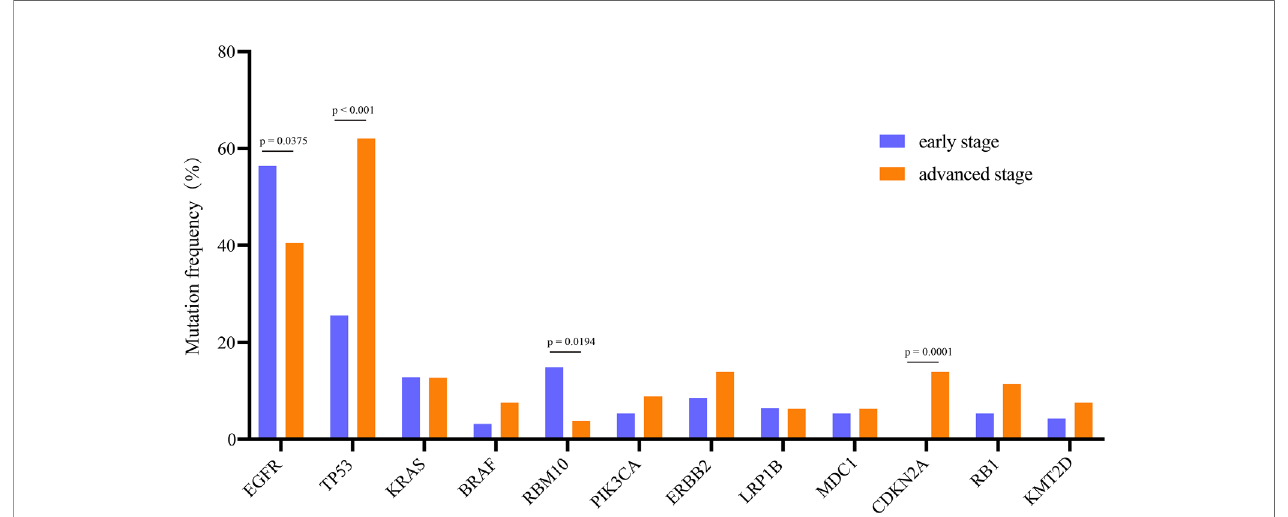
FIGURE 3 | Comparison of the prevalence of frequently mutated genes in early stage and advanced-stage NSCLCs. The commonly mutated genes are arranged in order on the horizontal axis. The vertical axis represents the mutation frequency obtained from a different